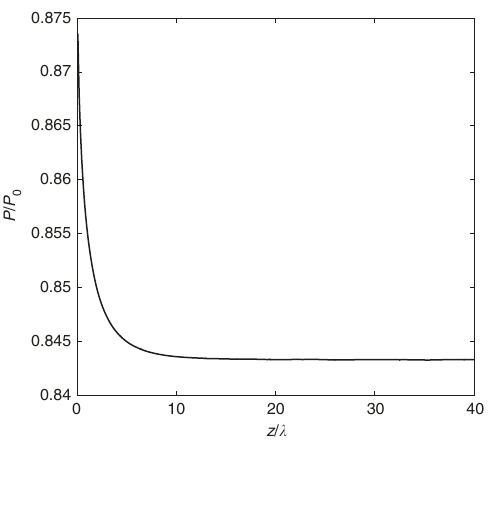
Fig. 6 Vapour pressure P normalized to P 0 as a function of the distance to the interface z normalized to the vapour mean free path for u K / u s =